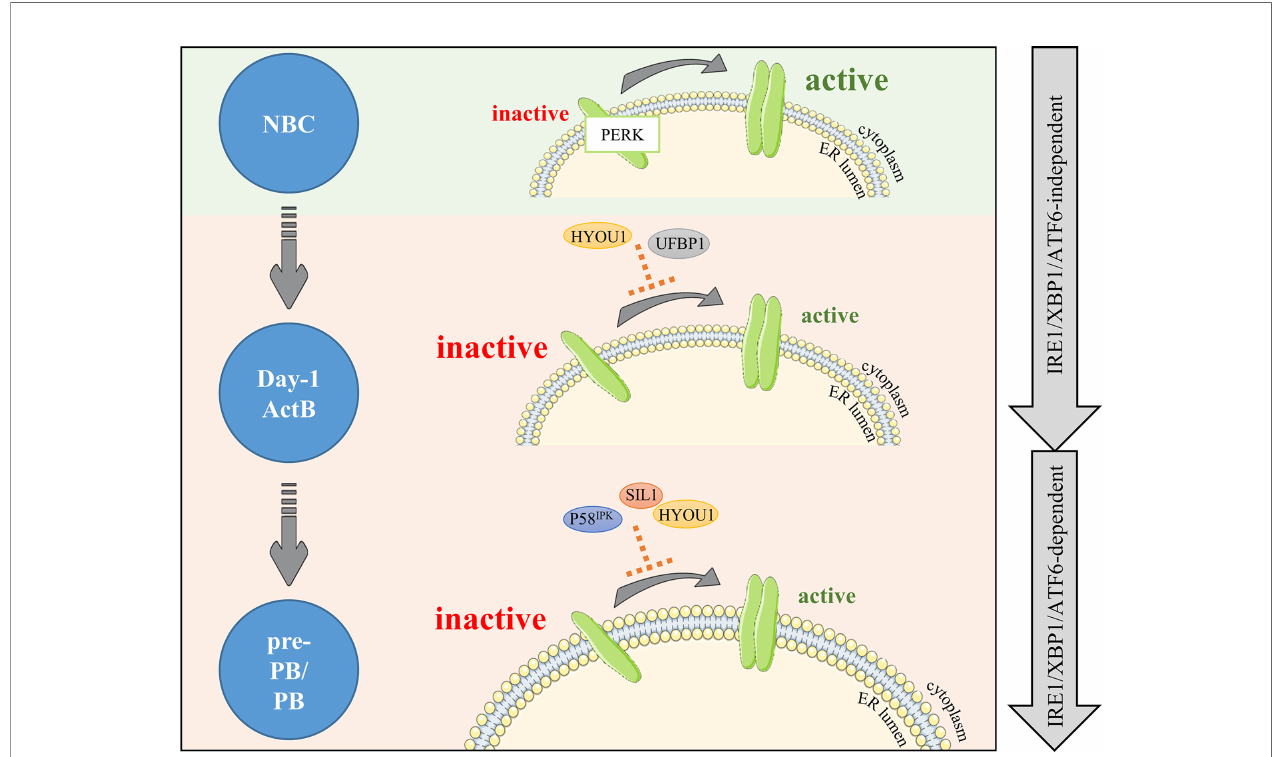
FIGURE 4 | PERK is negatively regulated right after B cell activation and maintained under negative control during differentiation. PERK signaling is upregulated in NBCs (light green background). In activated B cells, PERK needs to be dampened by factors limiting PERK activity (light orange background). Our RNA-seq analysis combined with literature emphases on two new potential negative factors: HYOU1 and UFBP1. Then, differentiation (pre-PB/PB) involves important changes including increased production of Ig, which critically increases ER stress and risks of apoptosis; hence, PERK signaling repression needs to be reinforced. Factors potentially involved in this control are part of the ADP/ATP BiP regulation cycle: the DnaJ protein P58 IPK and the nucleotide exchange factors SIL1 and HYOU1. The fi rst wave of negative control is IRE1 a /XBP-1/ATF6-independent and the second wave is IRE1 a /XBP-1/ATF6-dependent (right gray